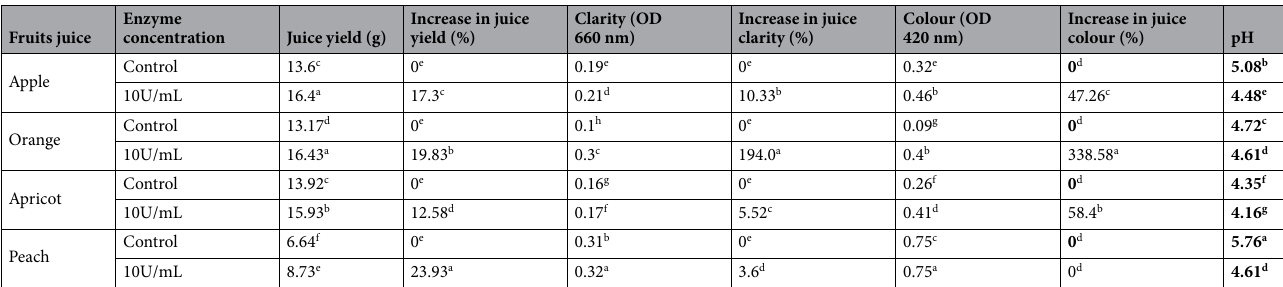
Table 4. Yield, clarity, colour and pH of apple, orange, apricot, and peach fruit juices treated with crude pectinase produced by Cladosporium parasphaerospermum AUMC 10865. At the 0.05 level of probability, means in a column with the same letters are not statistically different. Significant values are in